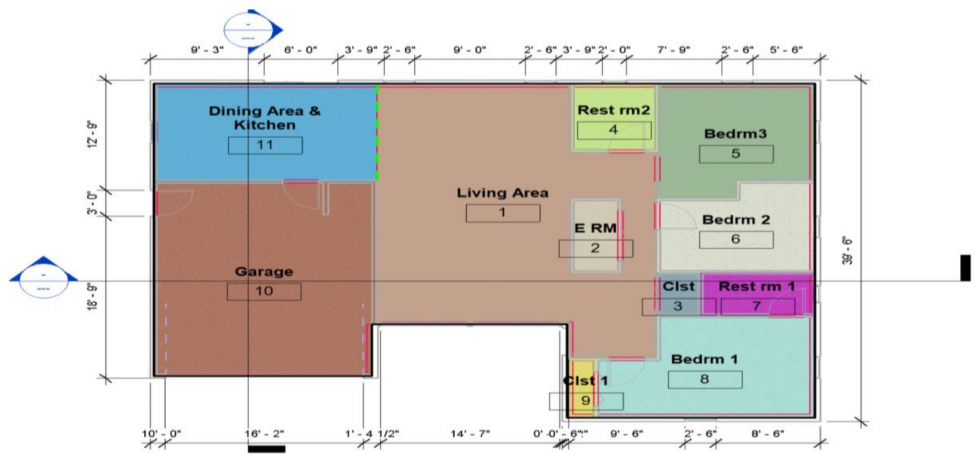
Figure 7. Floor layout of the baseline building.